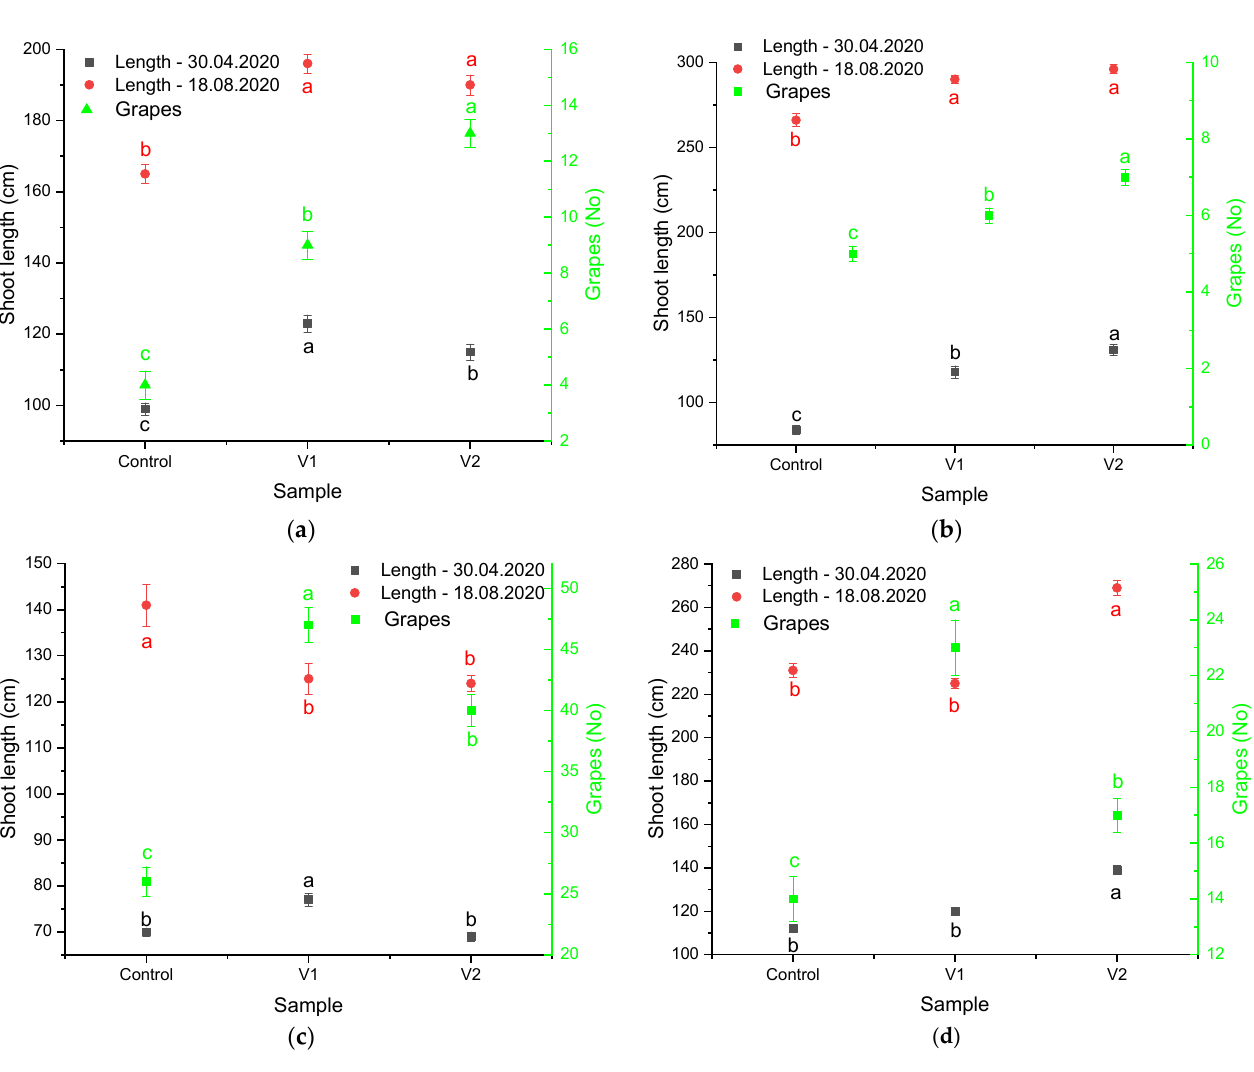
Figure 6. Influence of the applied treatments on young shoot length and number of grapes on the studied clones: ( a ) Feteasca alba 97 St; ( b ) Feteasca neagra 6 St; ( c ) Feteasca regala 72 St.; ( d ). Cabernet Sauvignon 131 St. The values represent means ± SD. Means of the same parameter (same color) without a common lowercase letter (a–c) differ ( p < 0.05) as analyzed by one-way ANOVA and the TUKEY test; V1 = alcoholic extract of D. filix-mas , V2 = silver nanoparticles phytosynthesized using the alcoholic extract of D. filix-mas , Control—chemical